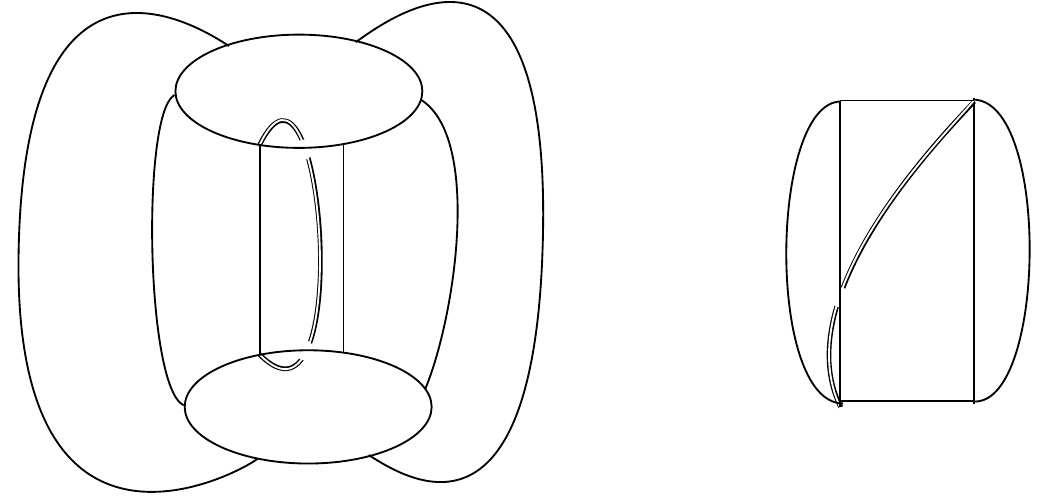
Figure 41 . Left: the only bi-pyramid contributing non-trivial signs to P v in the presence of an e particle. The quasi-particle is framed towards v and the decoration of the edges near v must (cid:13)ip from 1 to P or viceversa. Right: an example of a pillowcase contributing a non-trivial sign to U e There is a potential sign whenever the quasi-particle is framed towards an oval face, i.e. the earliest vertex of a face (\0") is opposite to the edge e . Then the sign measures the presence of P